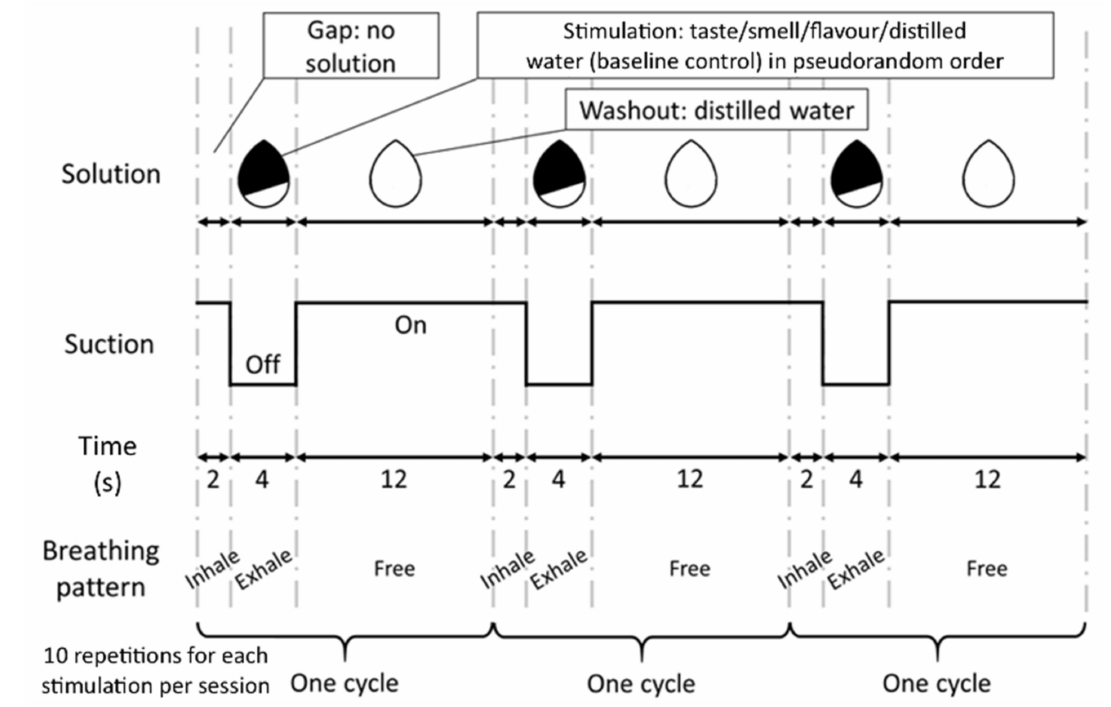
Figure 1. Experimental paradigm. The schematic diagram shows the three cycles of stimulation and washout, which were controlled by the delivery system. The first row represents the pattern of solution flow. The second row represents the period of suction operation. The third row represents the corresponding time for each period in seconds. The fourth row represents the instructed breathing pattern. During the first 2 s in each cycle, subjects did not receive any solution and were required to inhale. In the next 4 s, subjects were required to exhale gently and sense the stimulant (sour taste, mango smell, flavour of sour taste plus mango smell), or control (distilled water). These testing agents were delivered in pseudorandom order to avoid correct anticipation that might confound the brain activity signals. Afterward, subjects were free to breathe in the washout period. This washout period lasted for 12 s until subjects felt no solution being received, which indicated the start of the next cycle. Each stimulant and control were presented 10 times per session, resulting in a total of 30 repetitions per stimulus over the three fMRI